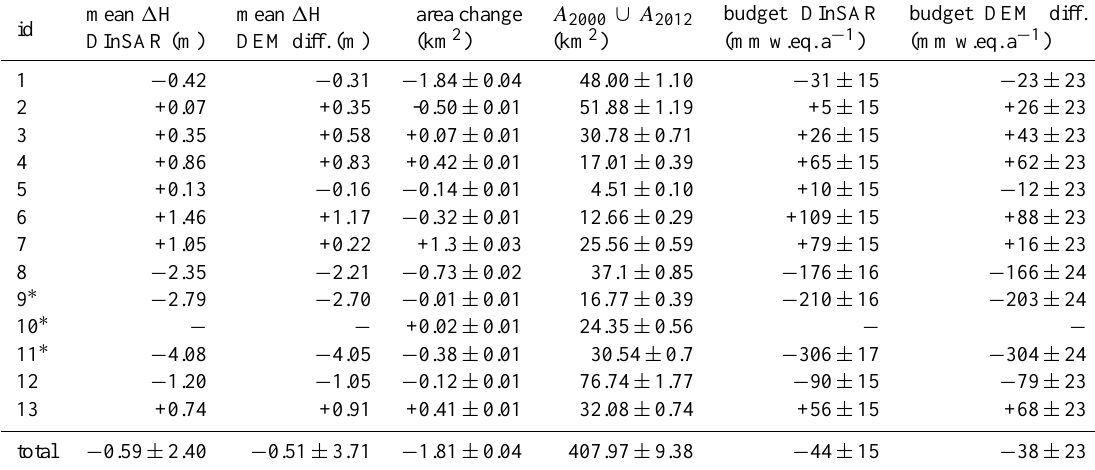
∗ Glacier is not or only partially covered by the interferometric data